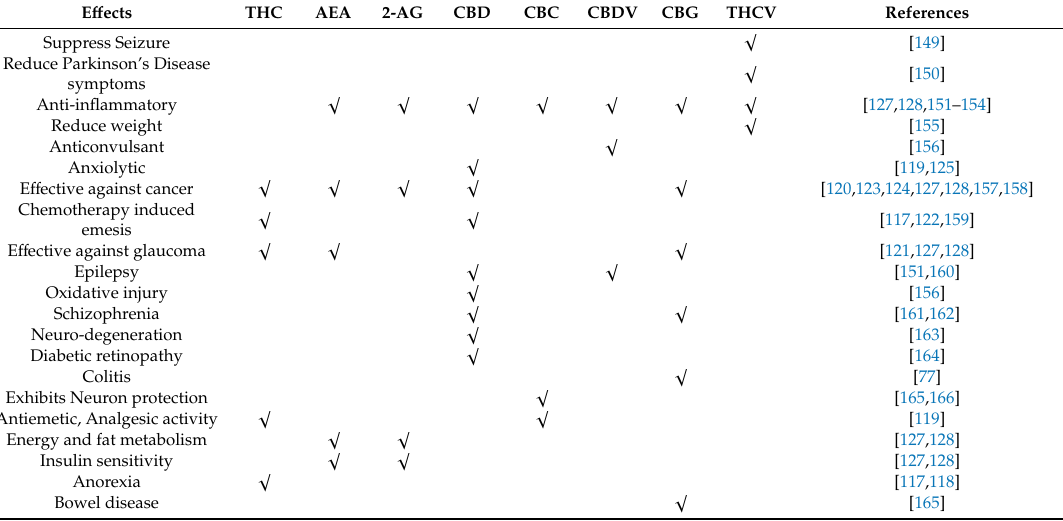
Table 1. Pharmacological and therapeutic e ff ects of endocannabinoids and